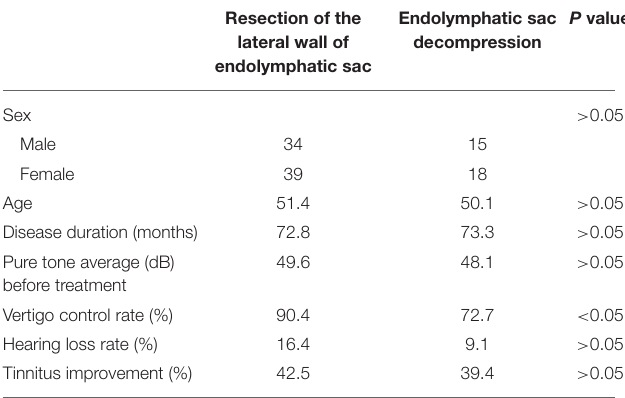
TABLE 1 | The demographic information and outcomes of patients with resection of the lateral wall of endolymphatic sac and endolymphatic sac decompression